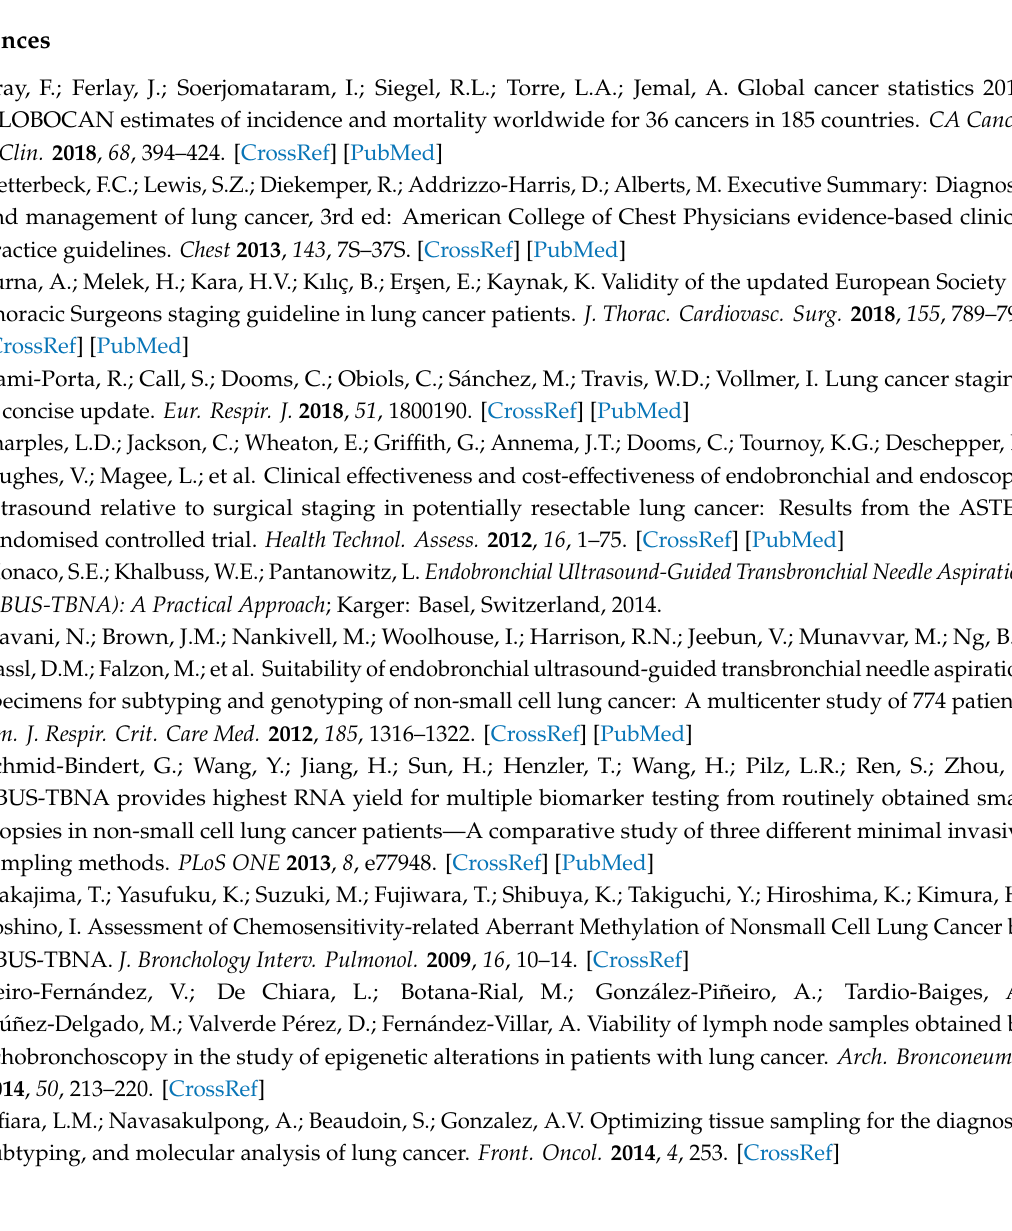
Table S1: Clinical characteristics of patients; Table S2: Sensitivity and specificity of the genes analyzed based on the Youden index; Table S3: Prediction of lymph node malignancy in individual patients based on Model 3; Table S4: Primers and probes